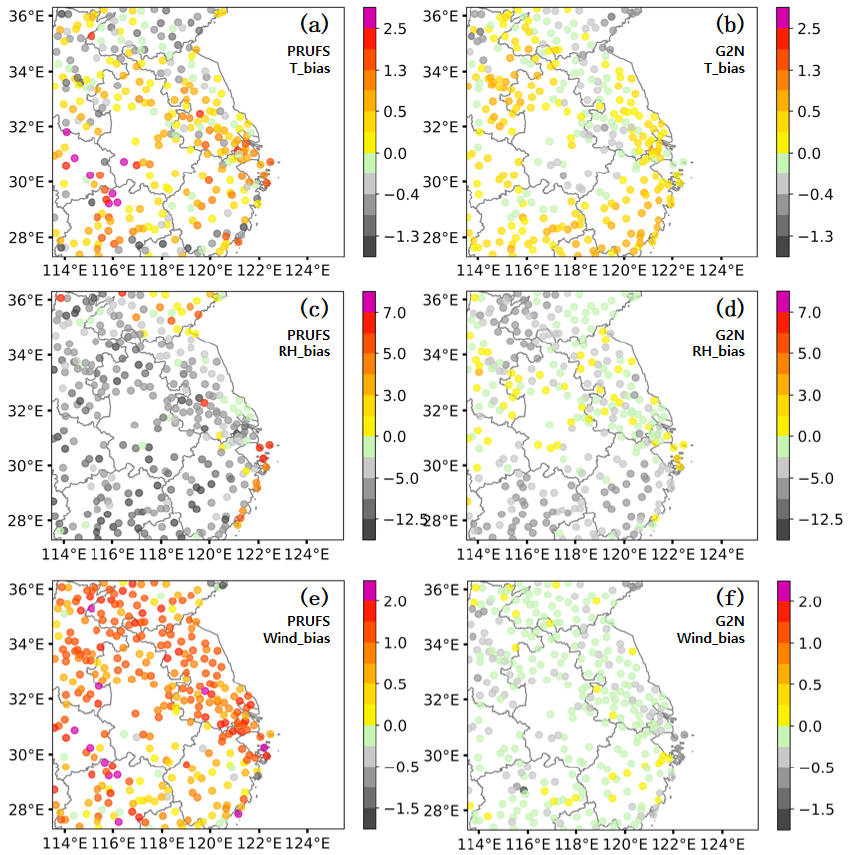
Figure 8. Horizontal distribution of the bias of the PRUFS forecasts ( left panels ) and the G2N correction ( right panels ) of 2 m temperature ( a , b ), 2 m relative humidity ( c , d ), and 10 m wind speed ( e , f ).